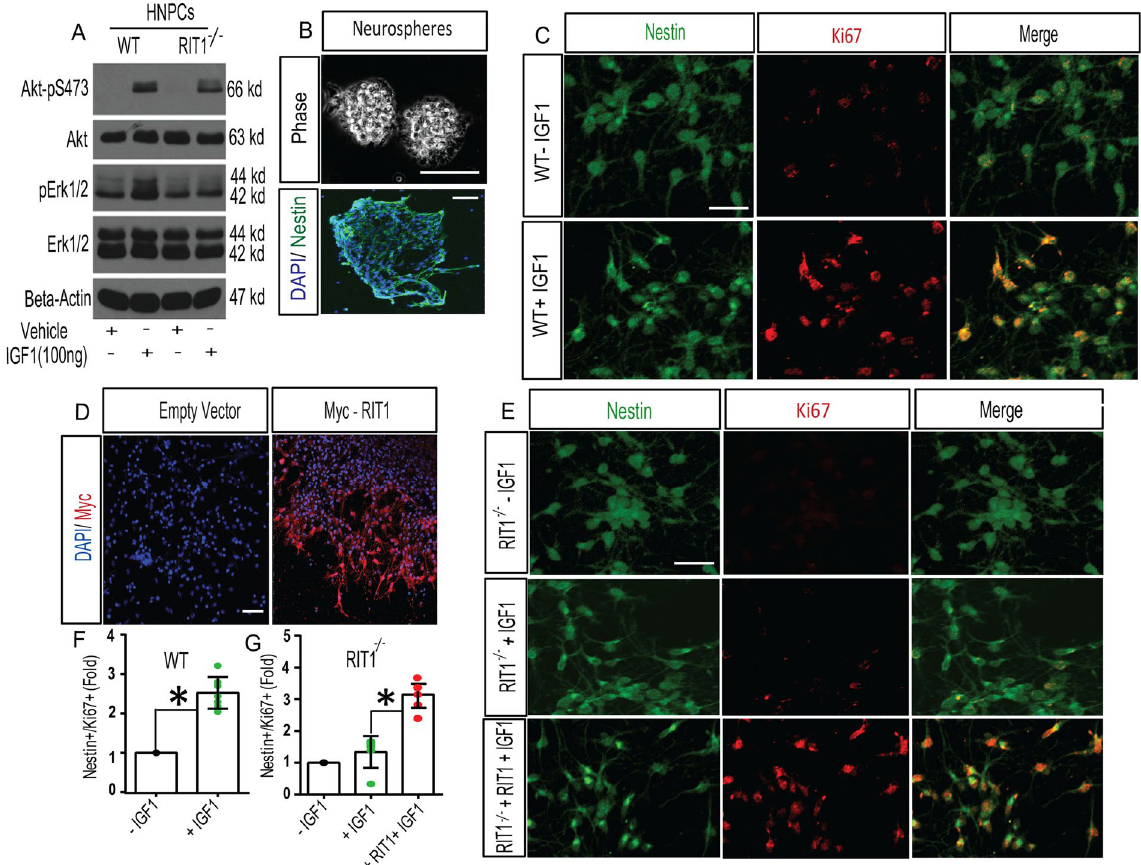
Figure 2. RIT1 loss disrupts IGF-1-mediated in vitro HNPC proliferation. ( A ) Lysates from cultured WT and RIT1 − / − HNPC cultures were analyzed by immunoblotting with the indicated antibodies following IGF-1 stimulation (100 ng/ml; 15 min). Representative images were cropped from the original blots run in parallel. ( B ) Phase contrast and immunocytochemical detection of Nestin ( green ) and DAPI ( blue ) of neurospheres clonally expanded from the dentate gyrus of wild-type mice. ( C ) Proliferation of WT HNPCs was assessed by immunocytochemical detection of Nestin ( green ) and Ki67 ( red ) 24 h following stimulation with or without IGF-1 (50 ng/ml). Scale bar, 15 μ m. ( D ) Representative confocal images of transfected Myc-tagged RIT1 ( red ) expression in dissociated WT HNPCs. Scale bar, 10 μ m. ( E ) Transfected RIT1 − / − HNPCs (Myc- tagged RIT1 or empty vector) were left untreated or stimulated with IGF-1 (50 ng/ml) and proliferation was assessed at 24 h by immunohistochemical detection of Nestin ( green ) and Ki67 ( red ). Scale bar, 15 μ m. ( F , G ) Quantification of IGF-1 mediated HNPC proliferation (Nestin + /Ki67 + )/200 cells counted from 5–6 fields in WT ( * p < 0.05 nonparametric one tailed t-test), RIT1 − / − , and following re-expression of Myc-RIT1 in RIT1 − / − HNPCs ( * p < 0.05, one-way ANOVA). Results are presented as mean ± SEM calculated from three separate